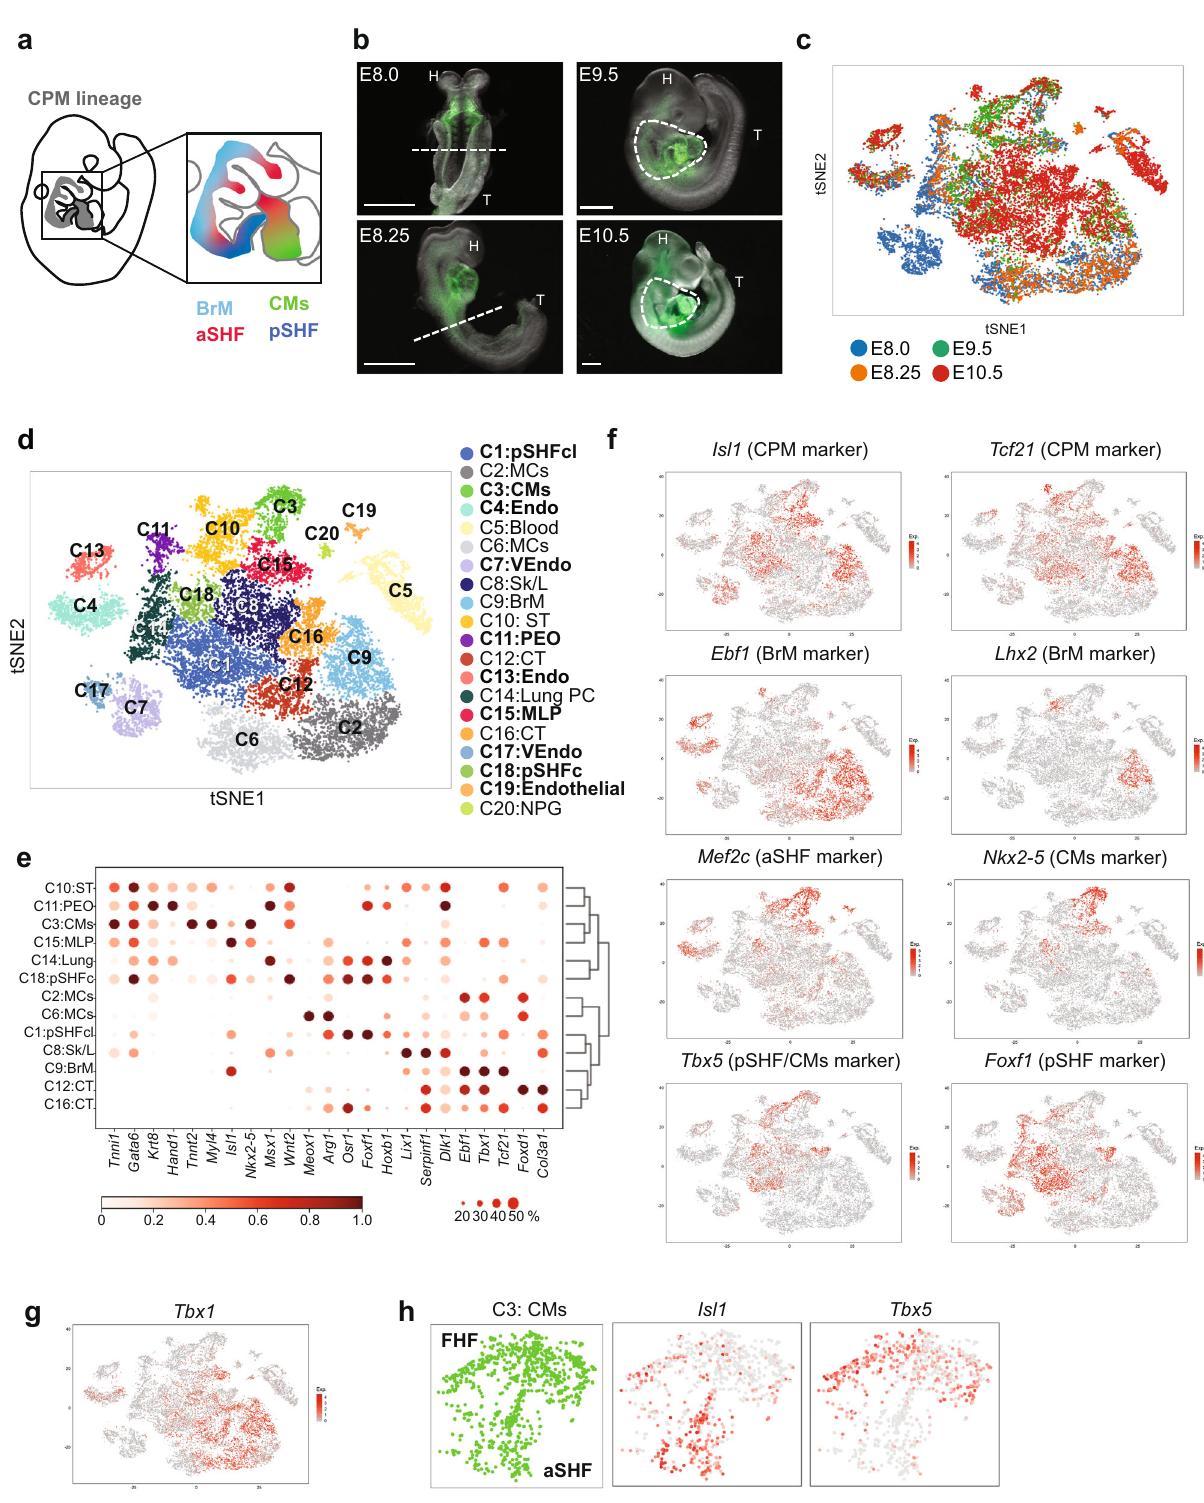
Based on the speci fi c expression of genes (Supplementary Data 1) and distribution of gene expression patterns in the PAGA plot (Fig. 2f and Supplementary Fig. 4d – f), we focused on two marker genes for MLPs, Aplnr (Apelin receptor) and Nrg1 (Neuregulin 1). Aplnr is expressed in the CPM 27 but not known for the speci fi c presence in MLPs, while Nrg1 is not known to be a CPM gene, but it is required in the embryonic heart for the development of the